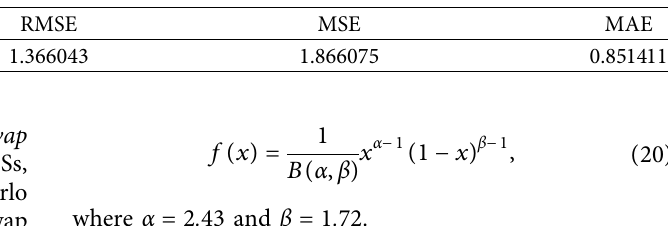
Figure 21: Comparison of prediction results. Table 8: Prediction error of the stacking ensemble